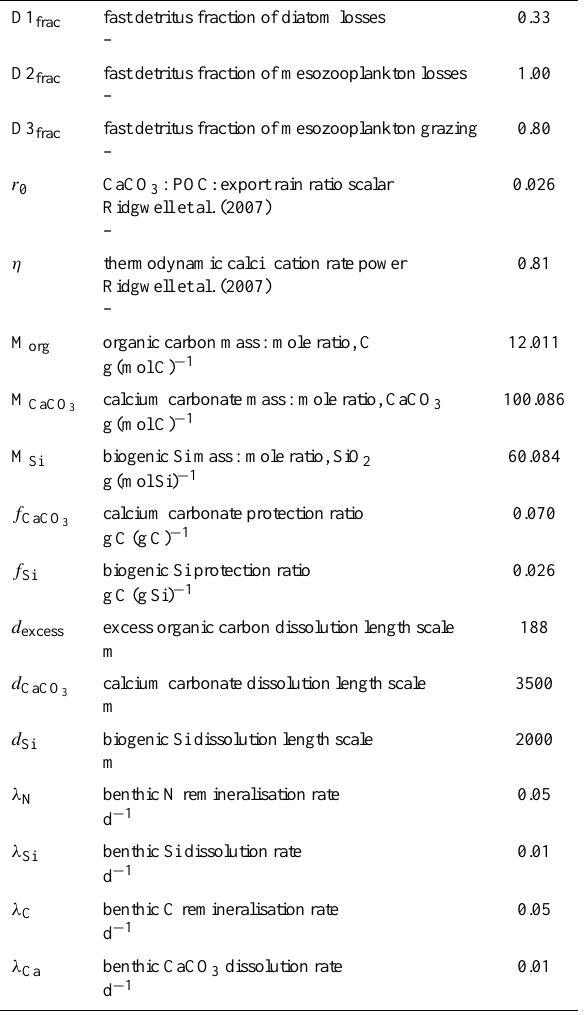
Table 5. Fast detritus submodel